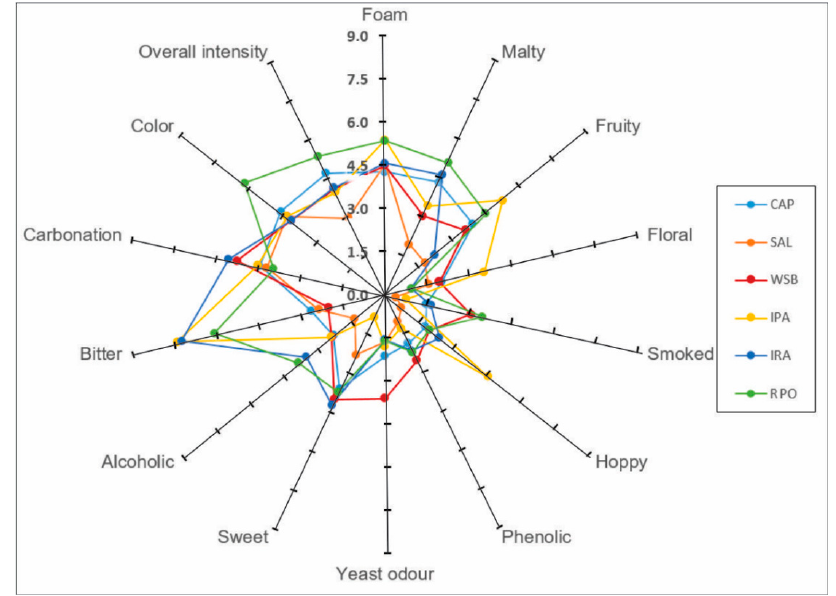
Figure 1. Plots of mean intensity scores for sensory profile of six different craft beers evaluated by quantitative descriptive analysis using a 9-point scale. Standard American lager (SAL), classic American pilsner (CAP), weissbier (WSB), American India pale ale (IPA), Irish red ale (IRA), and robust porter (RPO).